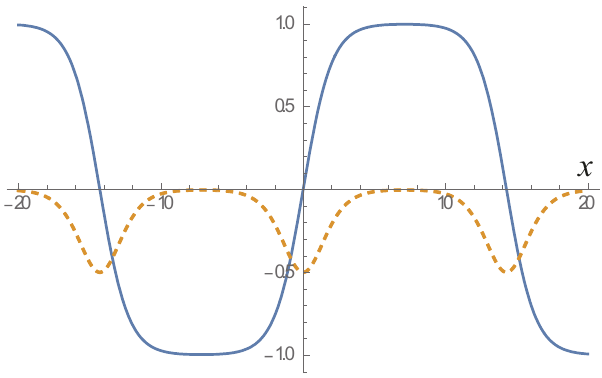
Figure 2 . The localized con(cid:12)ning soliton lattice con(cid:12)guration of (cid:27) (solid line) and (cid:21) (dashed line) for (cid:23) = 1 (cid:0) 10 (cid:0) 5 . Here we set, m = 1 and normalize the peak of (cid:27) to be 1. where s ( x ) = (cid:27) ( x ) =A and f CSL is the eigenfunctions obtained from eq. (2.5) for CSL n